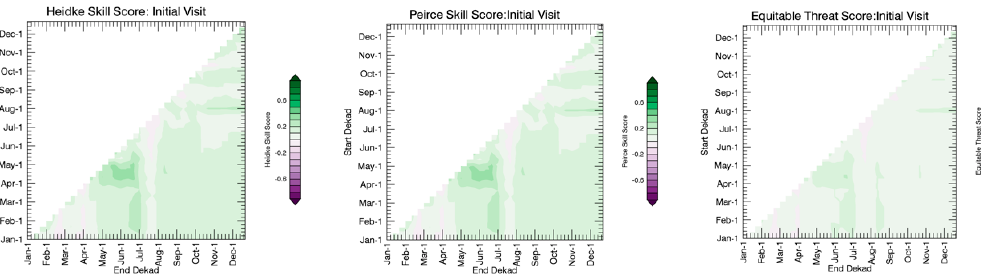
Figure 3. Heidke skill score, Peirce skill score, and equitable threat score for a variety of African Rainfall Climatology Version 2 (ARC2) rainfall accumulation intervals over the year. Higher skill scores reflect that the accumulation interval aligns better with farmer-identified payout years. The start and end dekads (on the y- and x-axis, respectively) indicate the 10-day period during the calendar that the accumulation calculation starts or ends. The lower-right portion of the graphic captures accumulation over the full calendar year, moving up from the lower right indicates a later start of accumulation, while moving to the left on the graphic represents an earlier end to the accumulation interval. Farmer-reported "bad years" on the initial visit to 21 villages in Tigray, Ethiopia, served as the truth data.